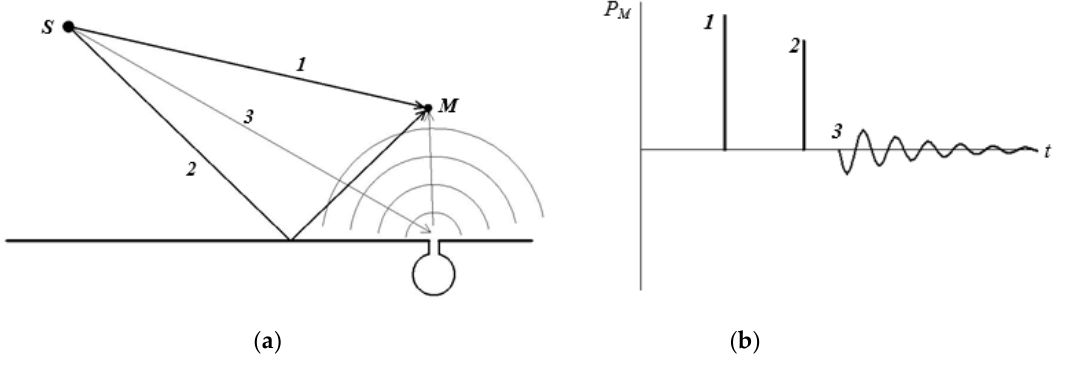
Figure 11. Effect of the resonator ( a ) on the impulse response ( b ). Figure 11. E ff ect of the resonator ( a ) on the impulse response ( b